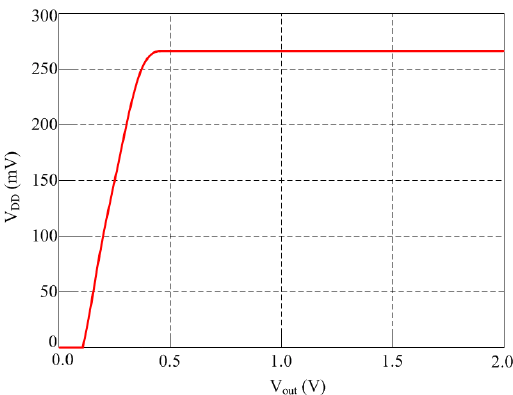
Figure 8. Proposed voltage regulator.